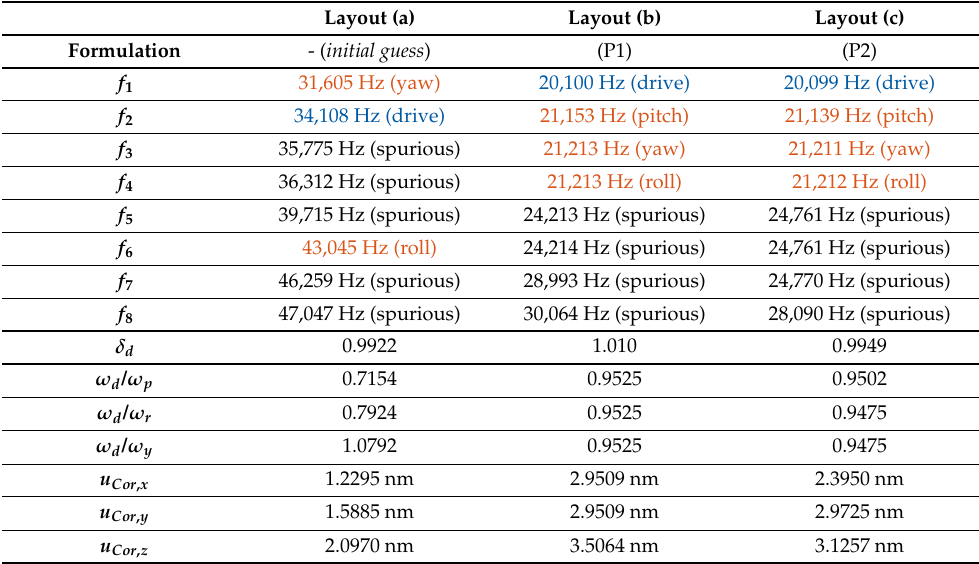
Table 3. Comparison of the different layouts shown in Figure 8 in terms of natural frequencies, drive mode shape parameter, and Coriolis displacements.